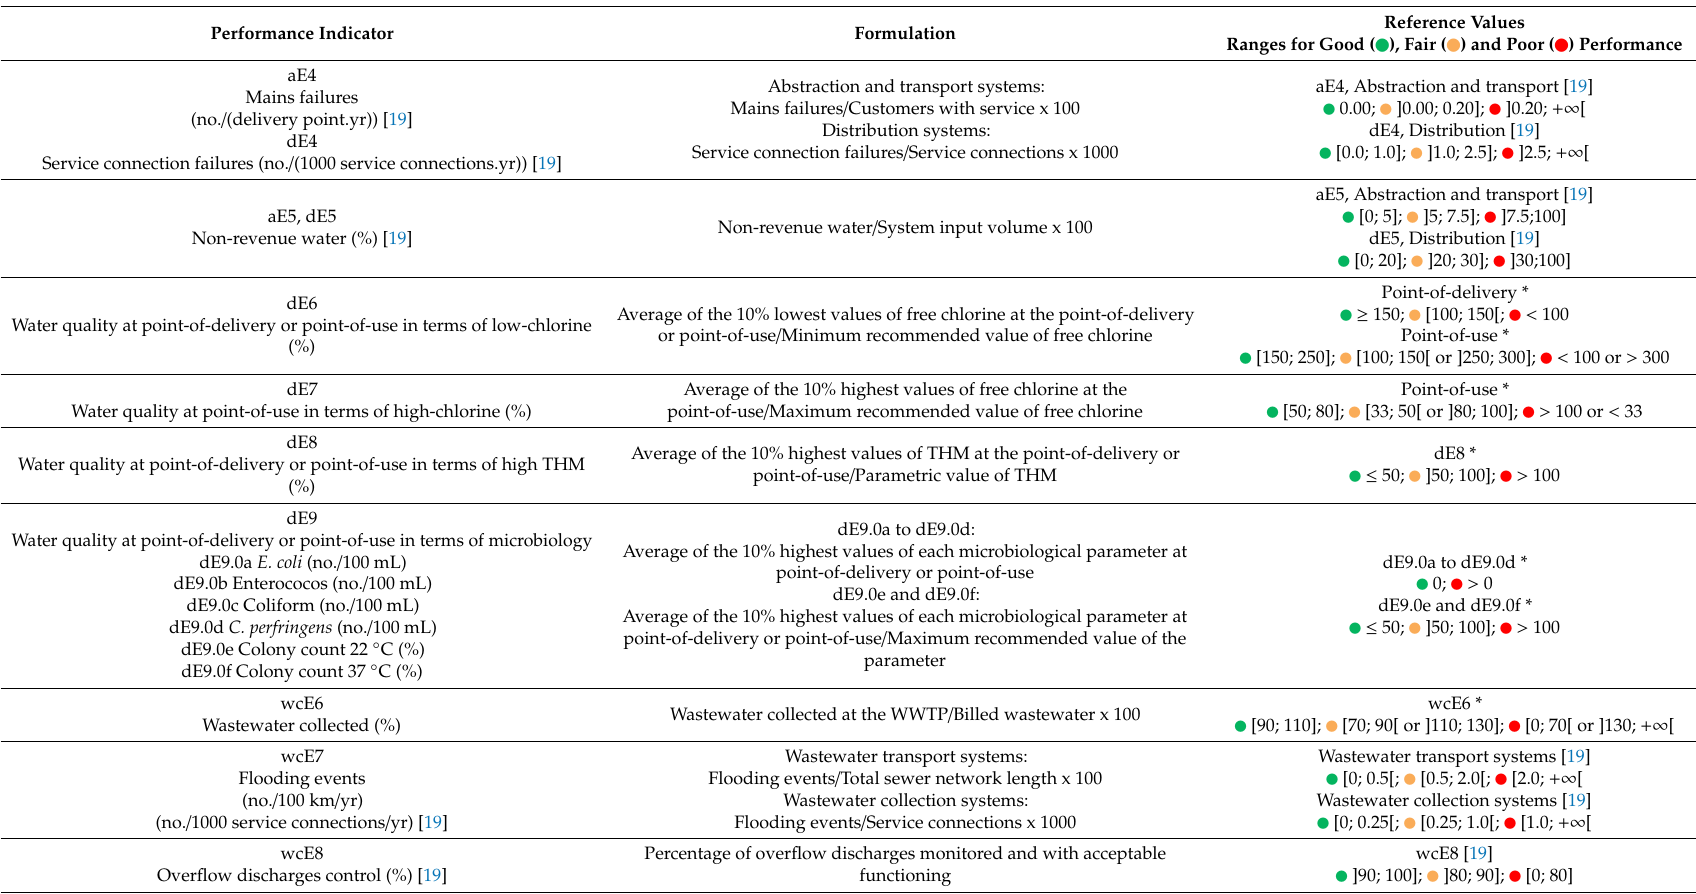
Table 3. Performance indicators for e ff ectiveness assessment, formulation and reference